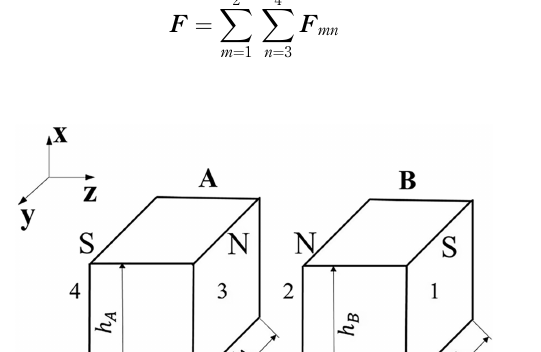
Figure 10. Schematic diagram of geometric dimensions and interval between two cuboid magnets